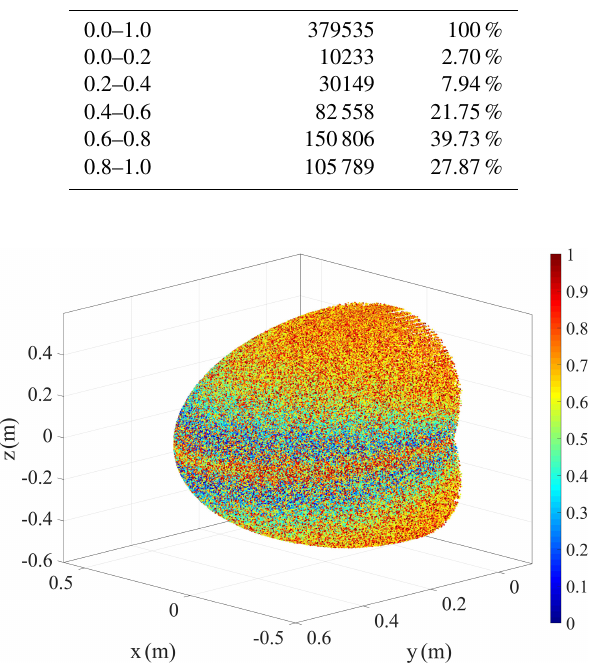
Figure 3. The figure of relative manipulability combined with the